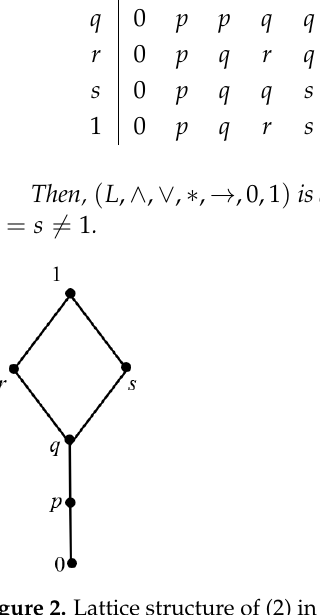
Figure 2. Lattice structure of (2) in Example